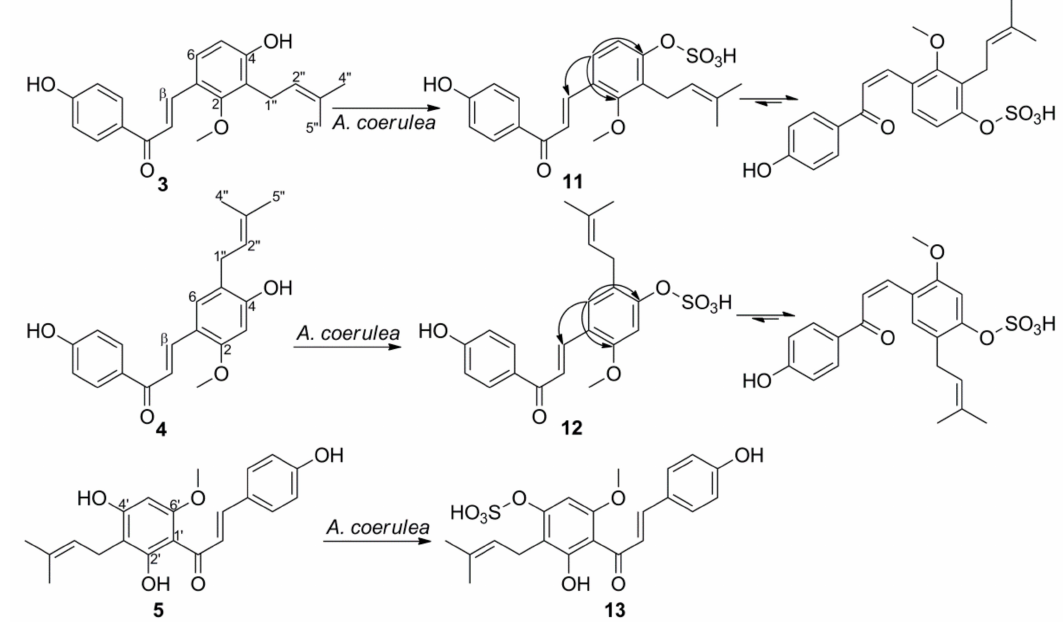
Figure 5. Microbial transformation of 3 – 5 by A. coerulea . Selected HMBC correlations ( 1 H → 13 C) of metabolites 11 and 12 are indicated by